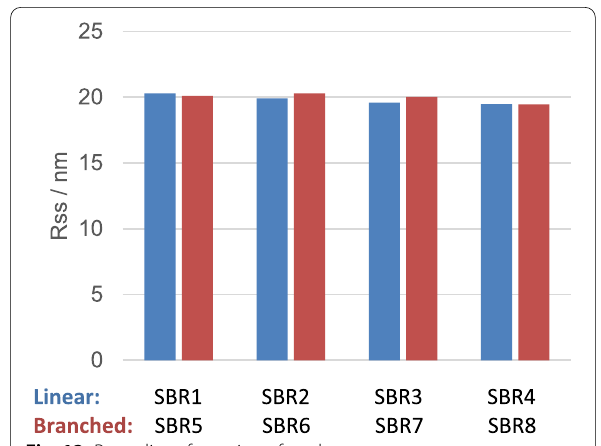
Fig. 12 Rss radius of gyration of agglomerates